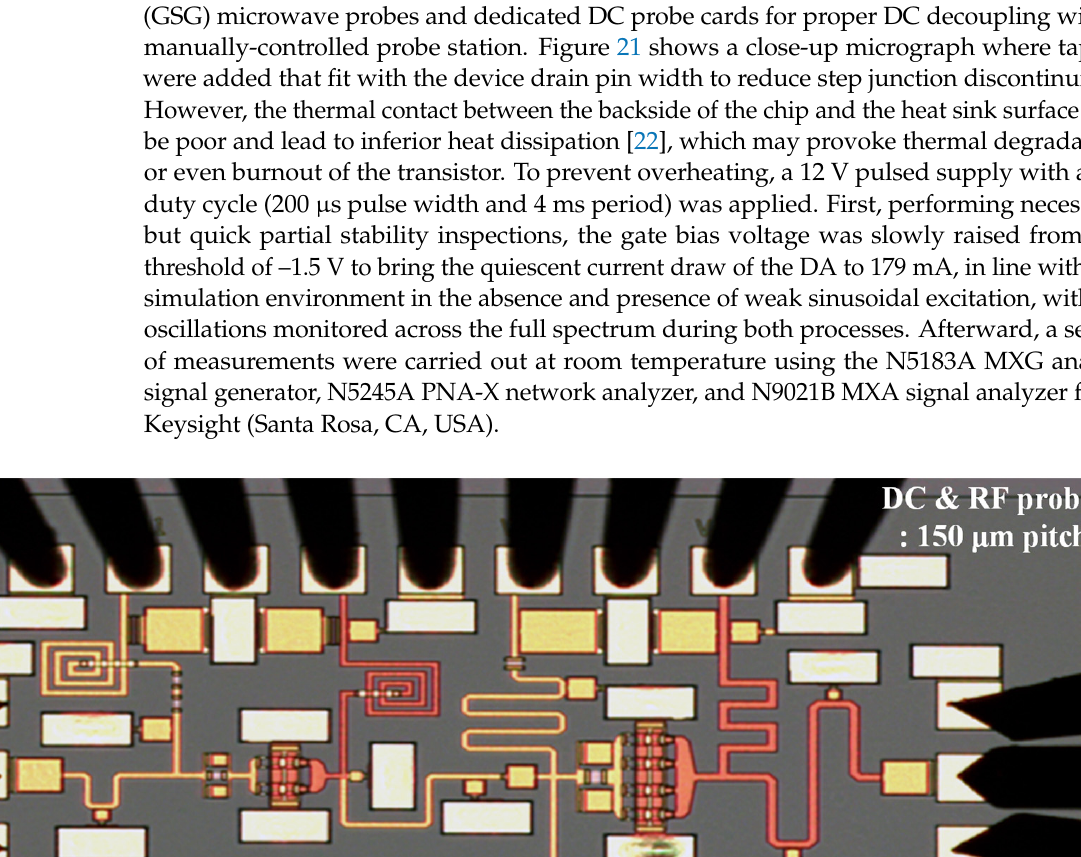
Figure 20. Stability factors of the final DA.